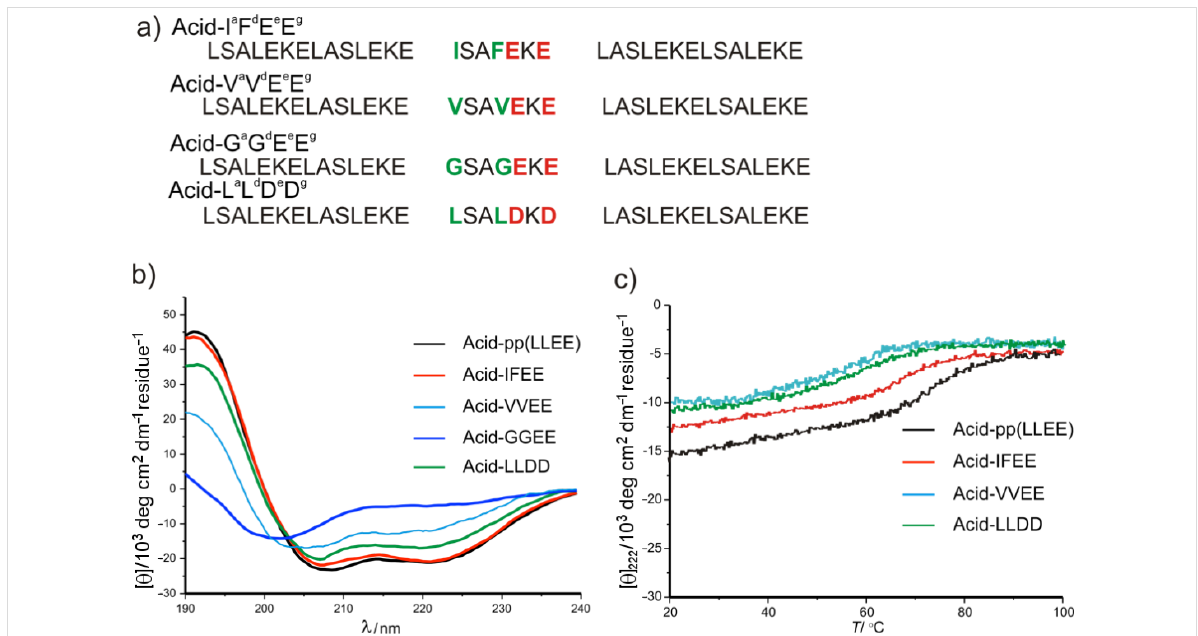
Figure 5: (a) The complete sequences of the selected α -mutants. (b) CD and (c) thermal denaturation spectra of an equimolar mixture of B3 β 2 γ and the α -mutants (25 μ M of peptide concentration in phosphate buffer 50mM in presence of 250 mM GndHCl).